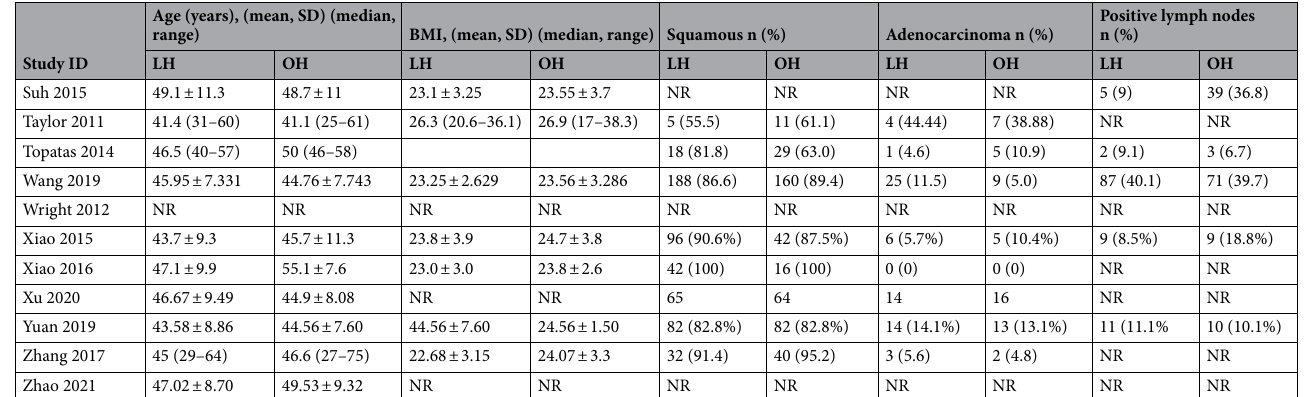
Table 2. Baseline characteristics of participants. NR not reported, n number, SD standard deviation.